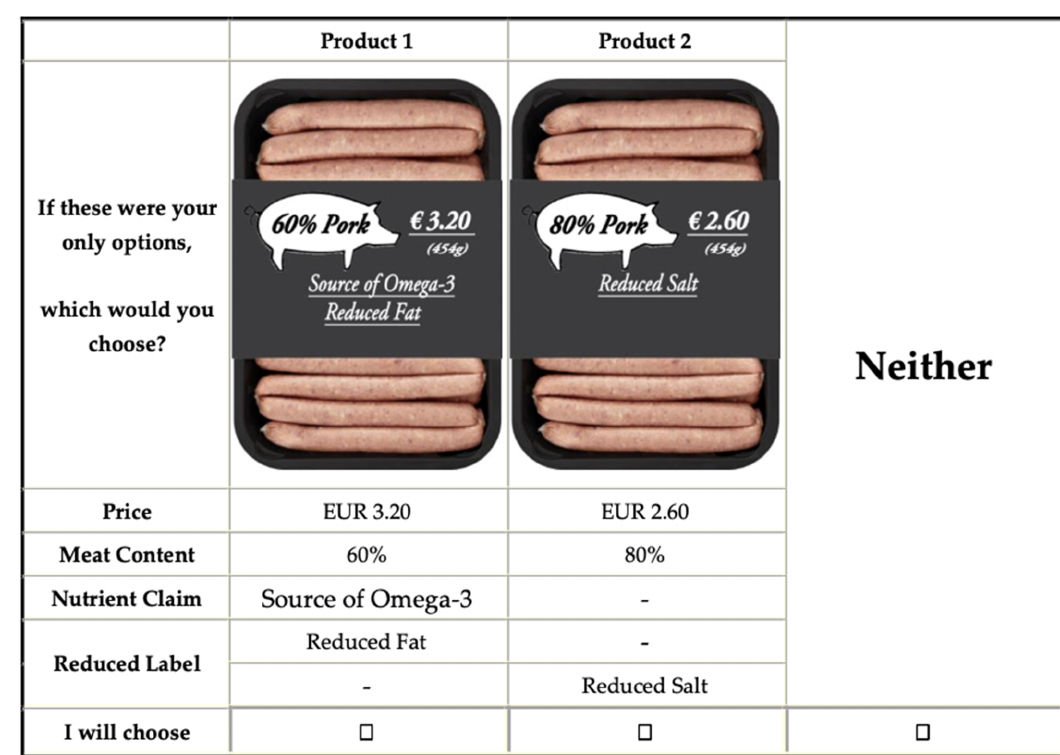
Figure A5. Choice set 5 in the questionnaire